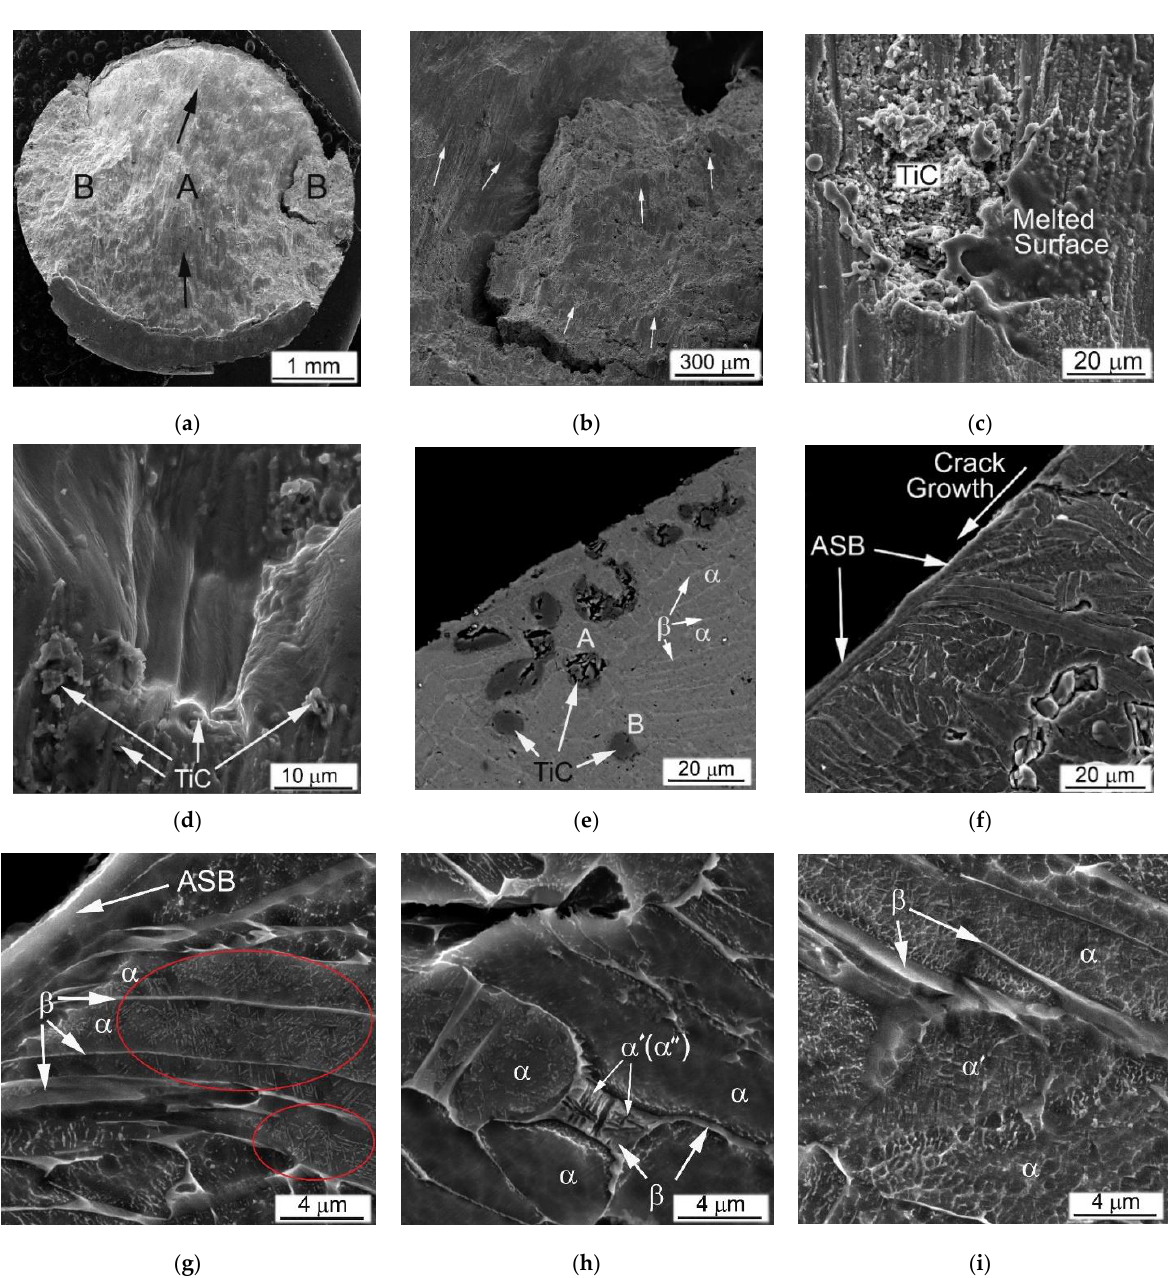
Figure 11. Fracture surface ( a – d ) and microstructure ( e – i ) of Ti64BEPM + 10TiC, SHPB tested with rate 1640 s −1 . Arrows in ( a , d ) indicate the direction of cracks growth. ( e – g ) Zone II; ( h , i ) Zone IV. Ovals in ( g ) indicate the areas within α- lamellas containing martensitic needles. The broken TiC particles near the main crack are A labeled in ( e ), while not broken particles a bit away from the main crack are B labeled. SEM, ( a – d ) ( f – i ) SE, (( e ), polished) BSE; ( f – i ) polished and etched. Images ( e – i ) are aligned with their vertical axis along with the acting external load like in Figure 8.